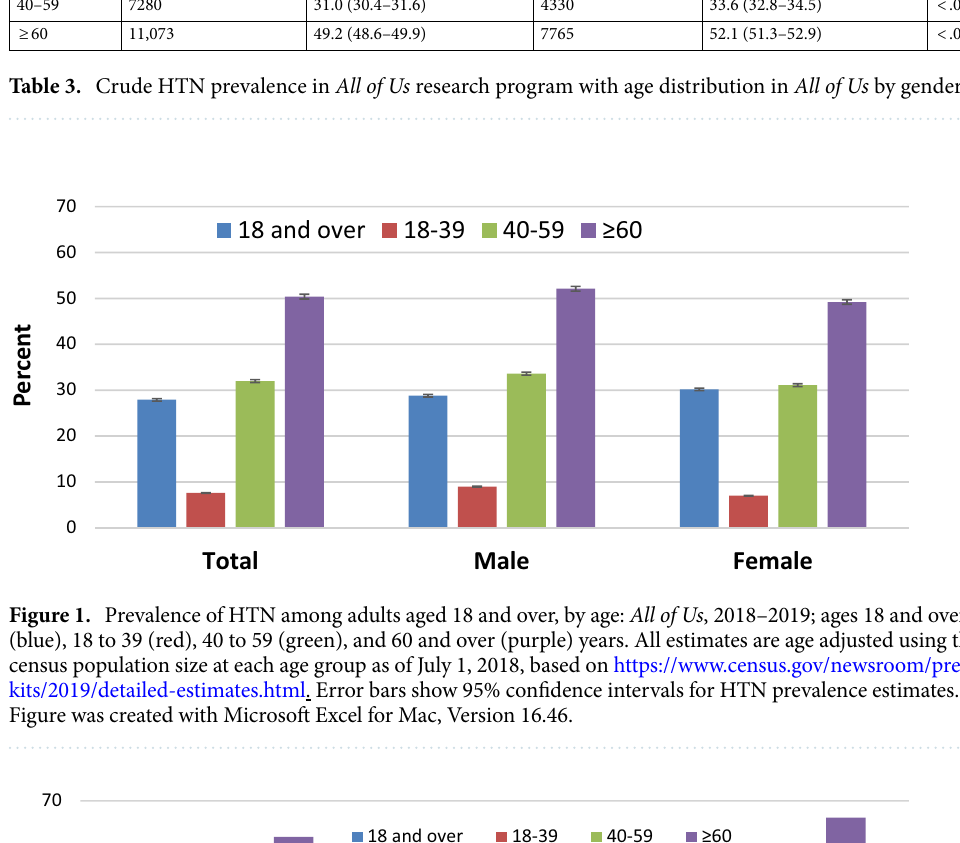
Female prevalence, % (95% CI)